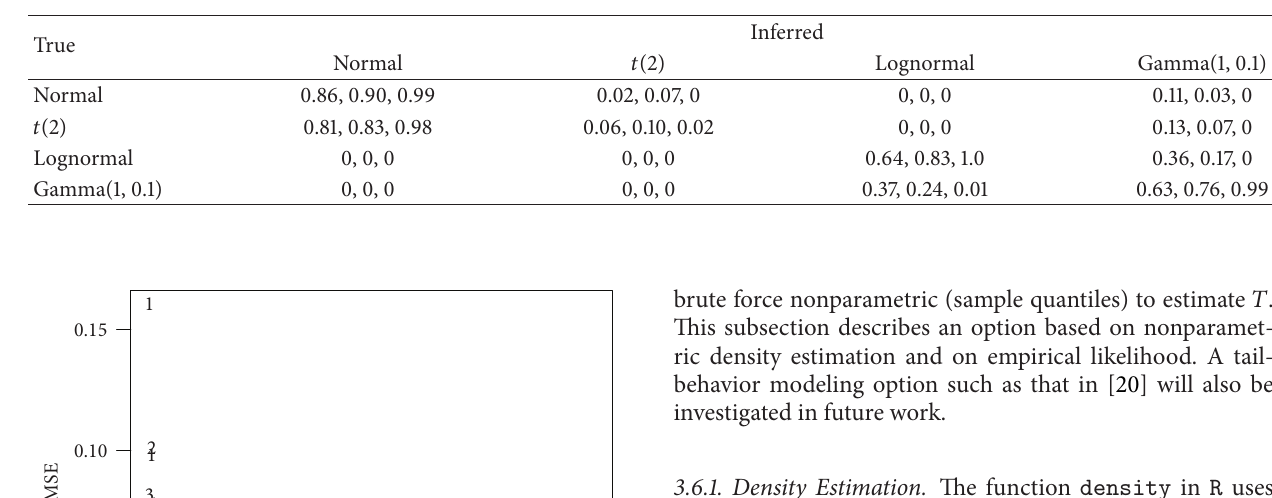
Table 1: The estimated probability rounded to the nearest 0.01 of inferring the likelihood model using BIC. The inferred likelihood is in columns and the true likelihood is in rows, for sample sizes 𝑛 = 25, 50, and 1000. The true likelihood is either normal, 𝑡 (2), lognormal, or gamma(1, 0.1) in the experiment.